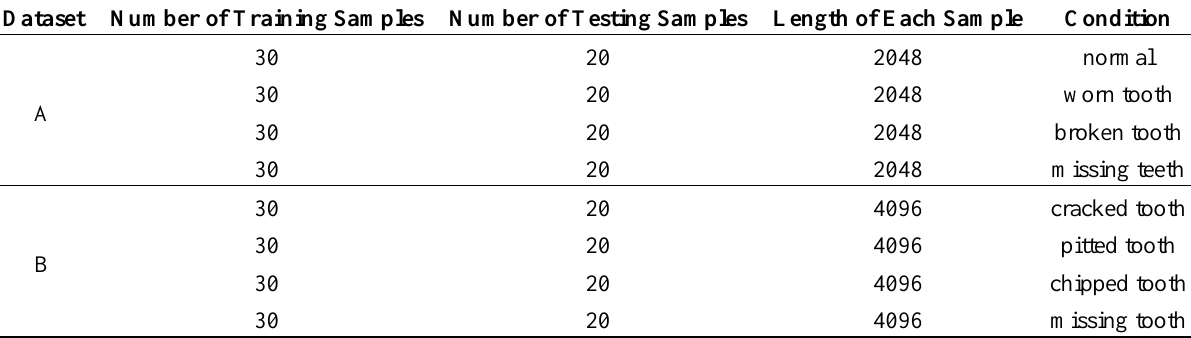
Table 1. The data sets for defect and severity